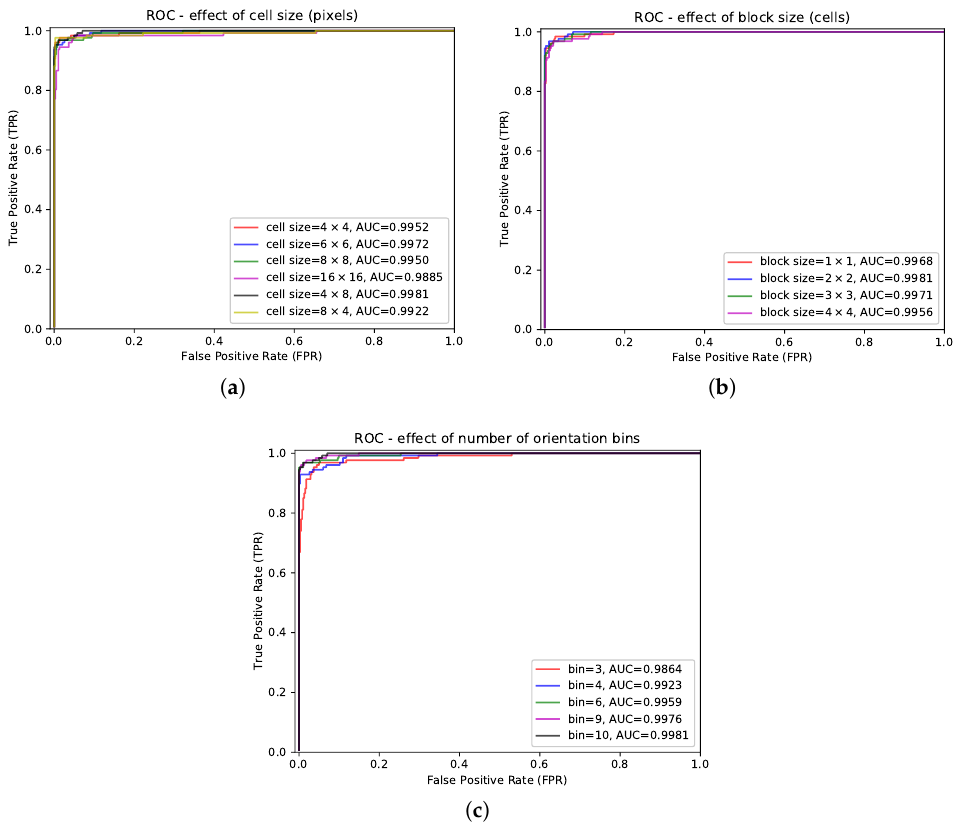
Figure 9. HOG feature performances with different specifications: ( a ) the effect of cell size (pixels), ( b ) the !effect of block size (cells), and ( c ) the effect of the number of orientation bins. The block size was tested with 1 × 1, 2 × 2, 3 × 3, and 4 × 4 cells. Figure 9b shows that the HOG feature with 2 × 2 cell blocks got the best